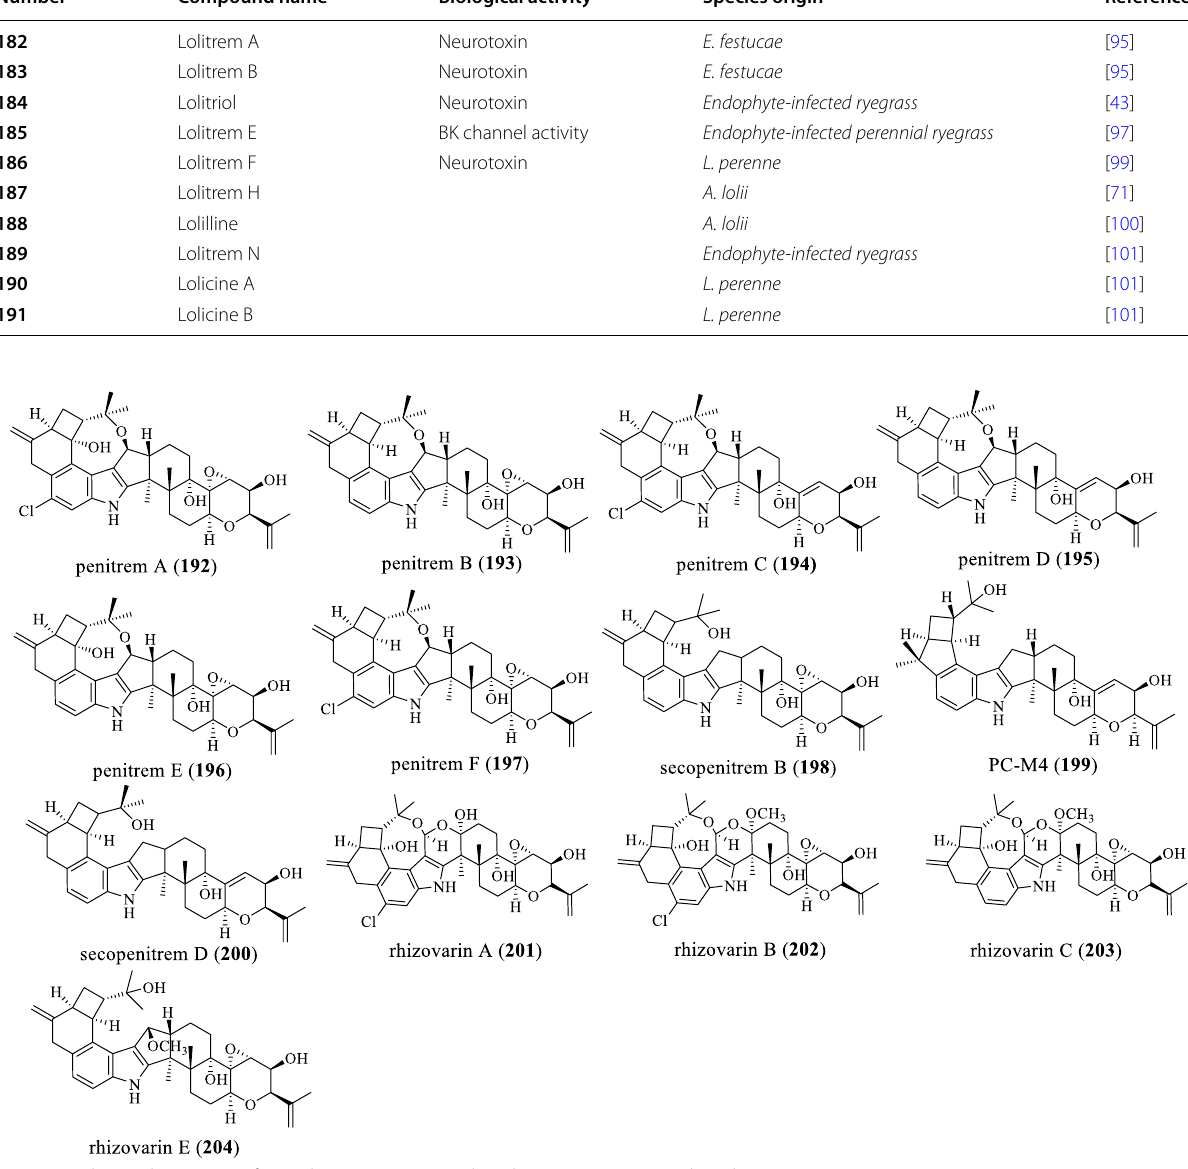
Fig. 13 Chemical structures of paspaline‑type compounds with A‑ring 4/5 or 6 membered